Question: What form of chart is displayed?
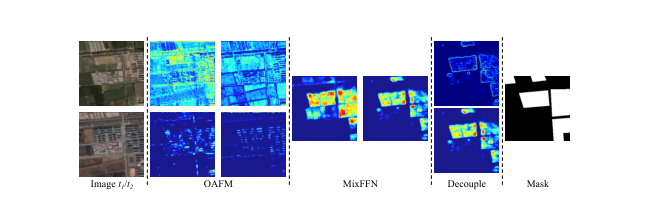
Answer: heatmap